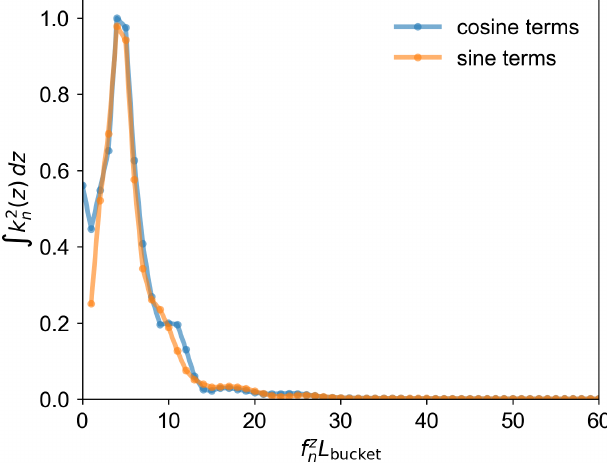
FIG. 4. Energy associated with the measured response func- ð z Þ . The curves are normalized to the maximum value. tions k n